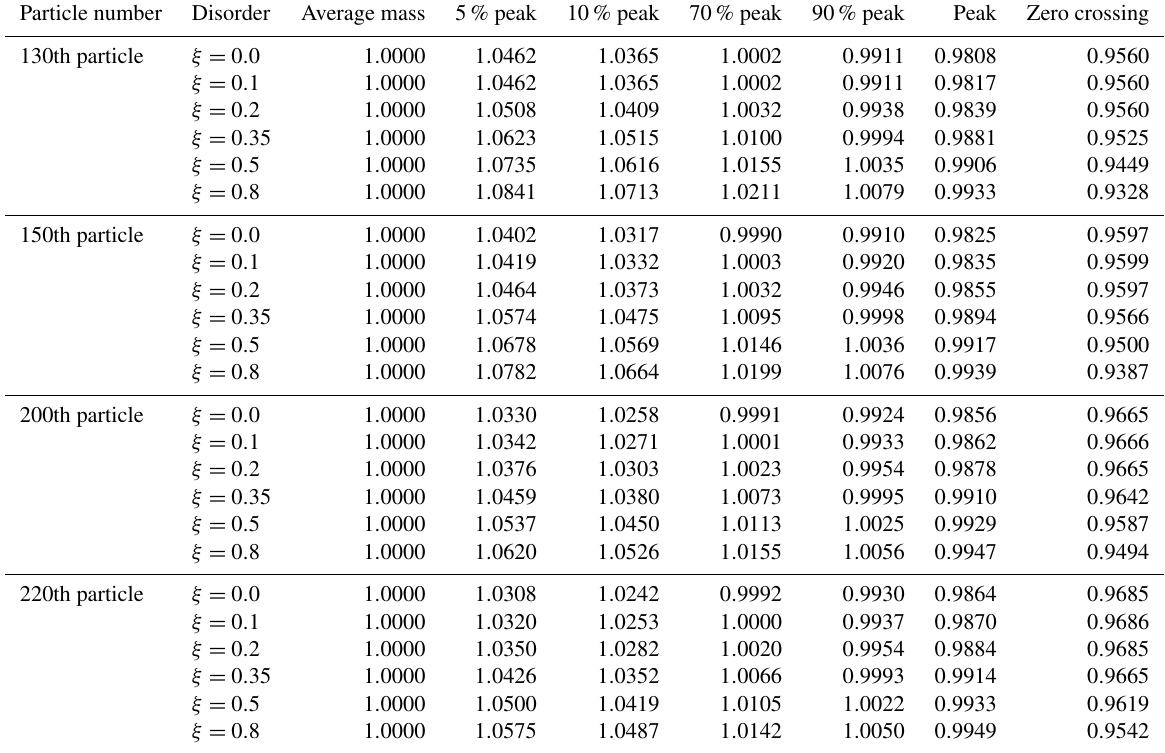
Table 4. Scaled coherent wave velocity picking for different particles before and after localization length for a disordered chain with normal distribution (256 elements long, 500